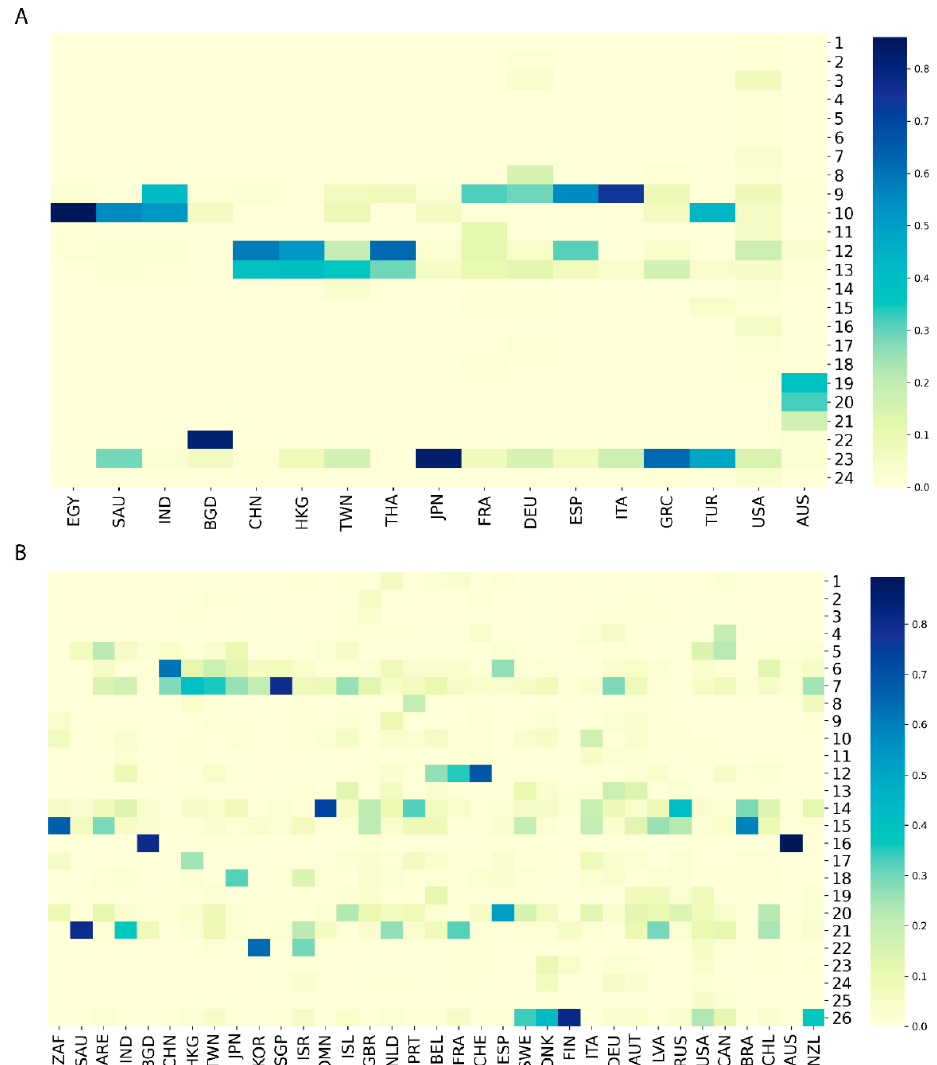
Figure 2. Distributions of SARS − CoV − 2 sequences in the major clades for countries from GenBank ( A ) and GISAID ( B ). Each column represents a country which is labeled with a three-letter country code. Each row depicts a major clade marked by its clade number. The color palette indicates frequency values of sequences in the major clades for individual